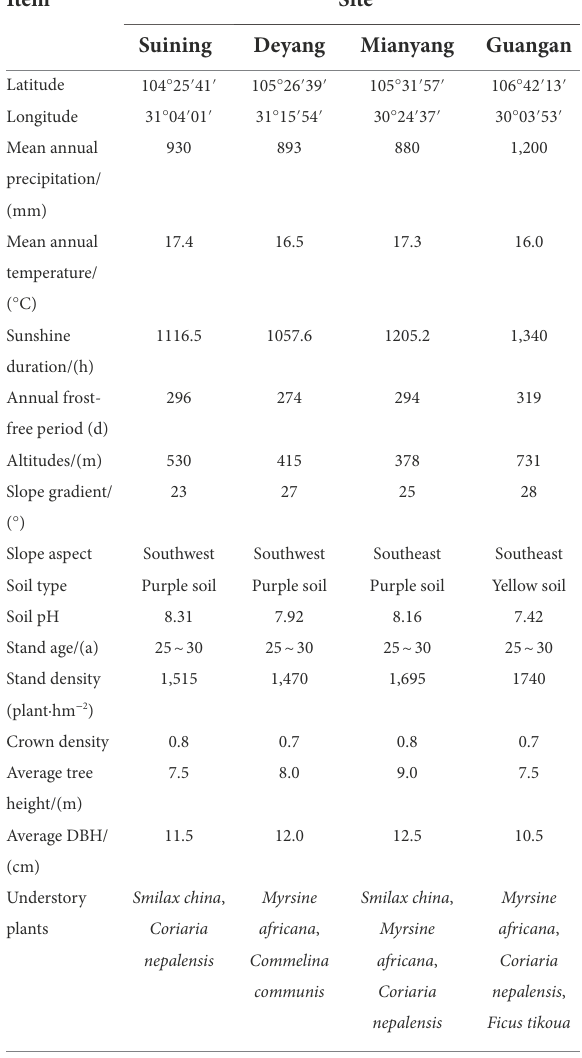
TABLE 1 Basic geographic information of four test